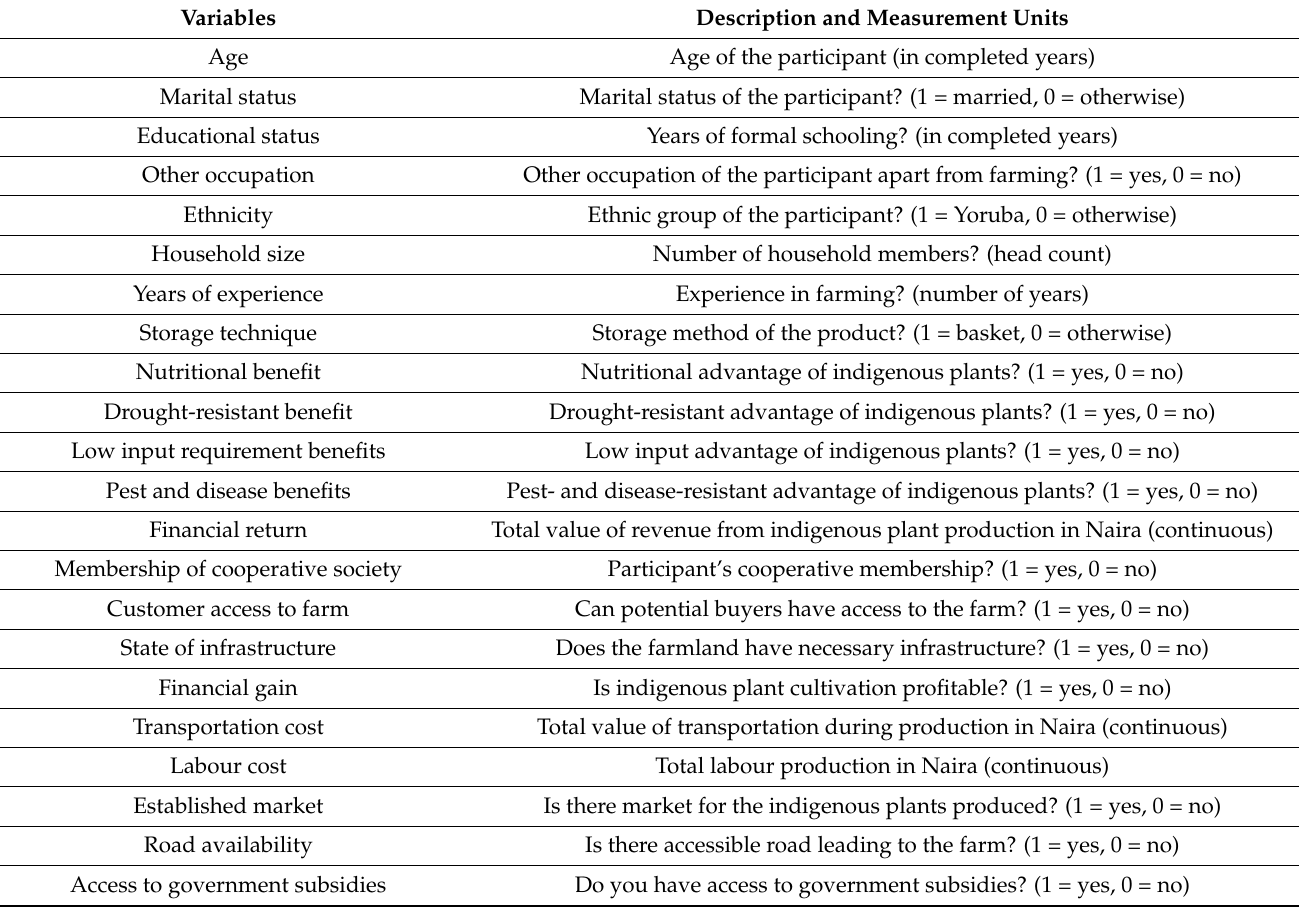
Table 2. Variables influencing the decision of participants to cultivate indigenous fruits and vegetables on their